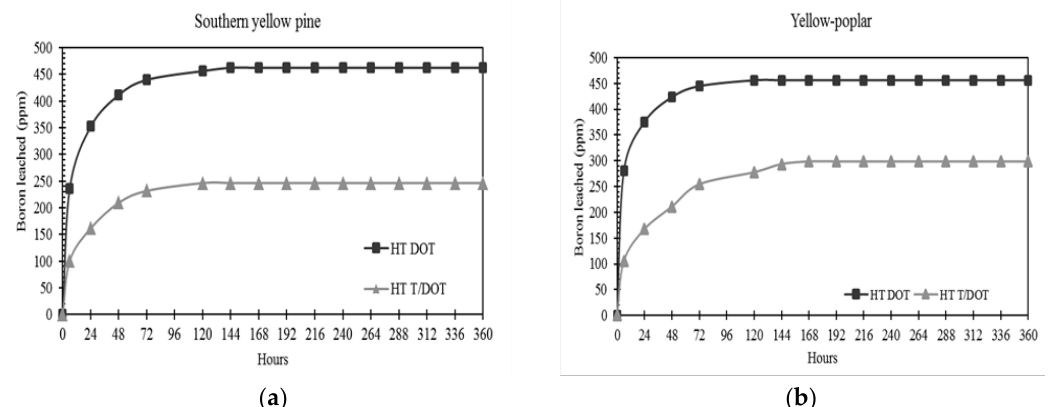
Figure 3. Cumulative boron leaching in southern yellow pine ( a ) and yellow-poplar ( b ).